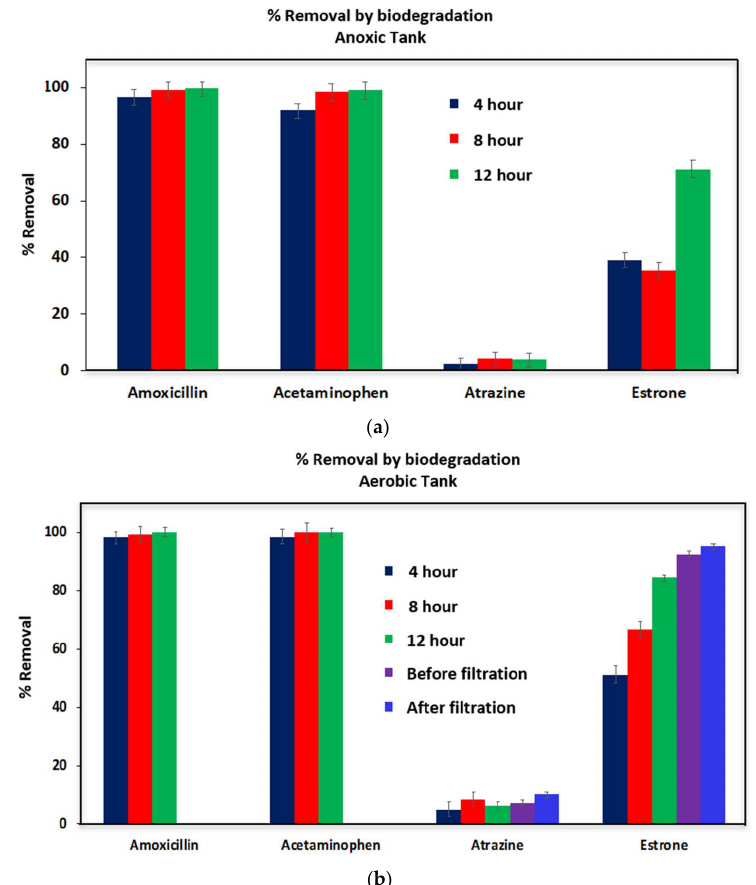
Figure 7. Percentage removal by biodegradation of the micropollutants in anoxic ( a ) and aerobic ( b ) tanks. The reference concentrations for the compounds were those measured at time zero.